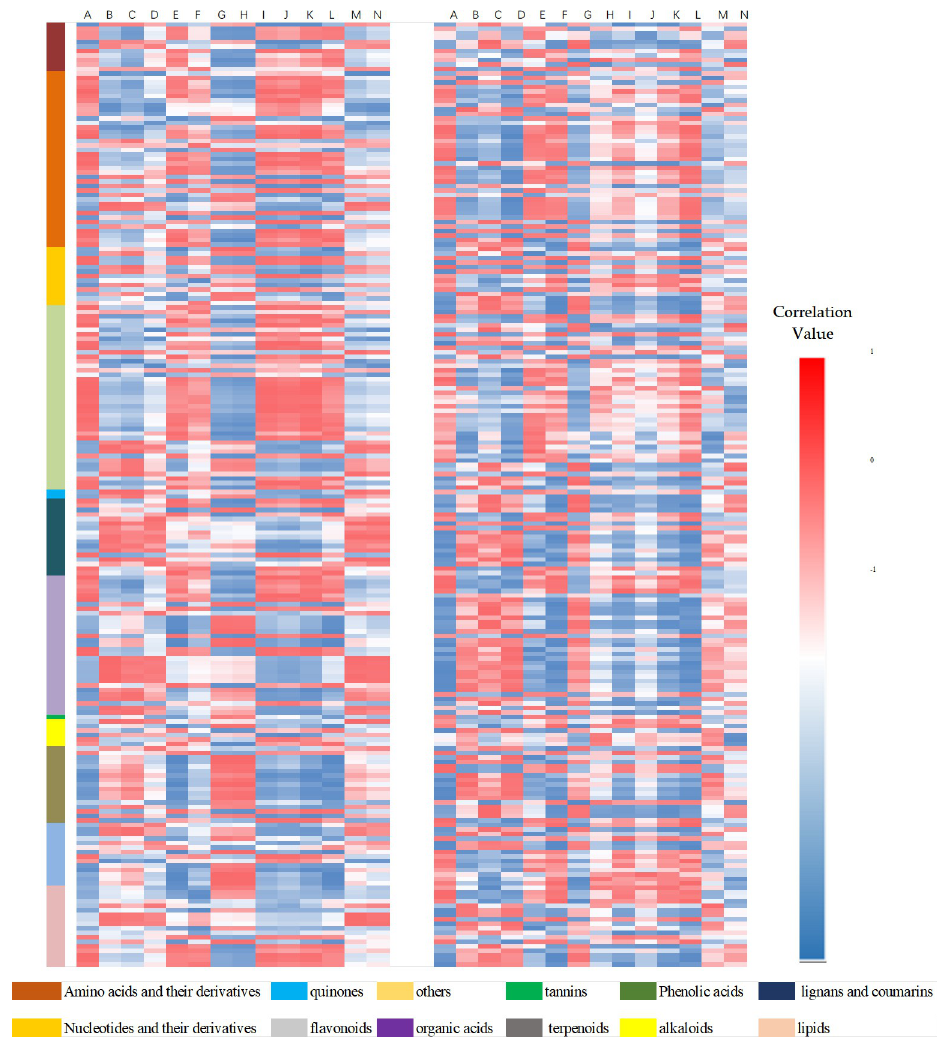
Fig 2. Correlation heatmap of the Forsythia related metabolites in leaves and fruits in each harvesting period. The two heatmaps represent the correlations between the metabolites and the Forsythia related metabolites in fruits and leaves, respectively. Heatmap of fruits was listed on the left and that of leaves was listed on the right. The left column of the heatmap shows the classification of different types of metabolites. Each Forsythia related metabolite is represented by a single column, as follows: A: forsythiaside C, B: forsythoside B, C: rengyoside B, D: rengyoside A. E: forsythiaside B, F: forsythiaside J, G: forsythiaside A, H: isoforsythoside A, I: forsythialan B, J: forsythialan A, K: phillygenin, L: phillyrin, M: 11-methyl-forsythide, and N: forsythide. Red and blue color represent positive and negative